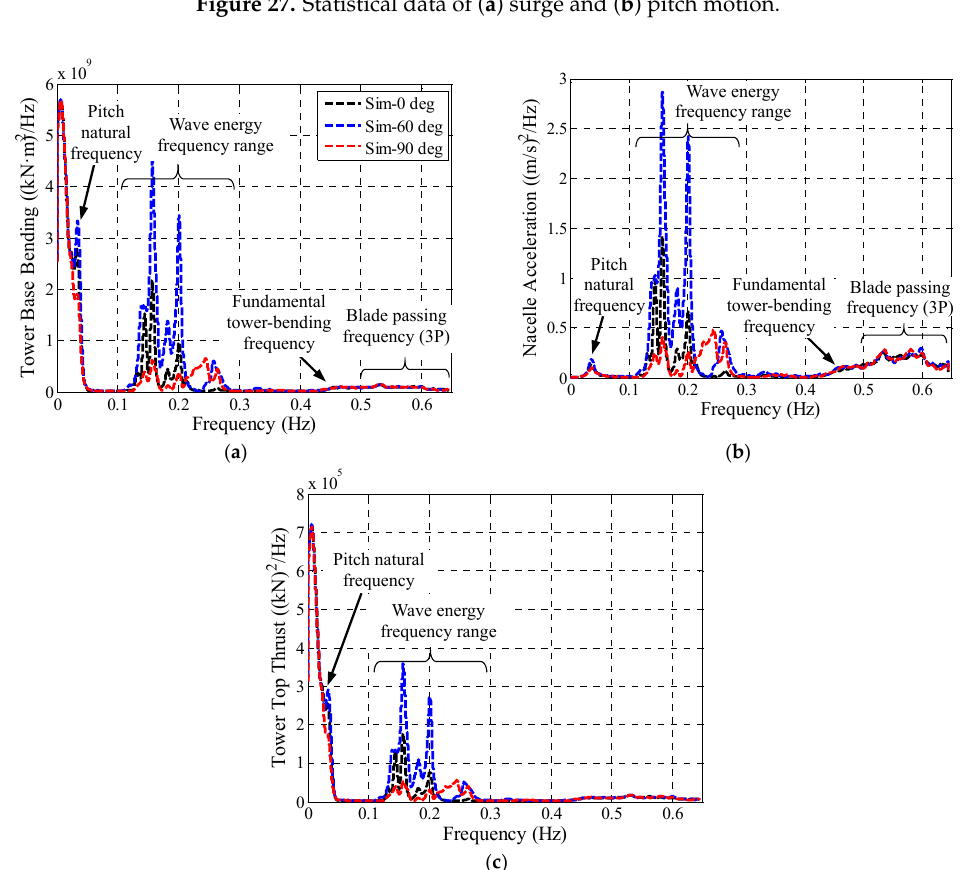
Figure 28. PSD plot of fore-aft ( a ) tower base bending moment, ( b ) nacelle acceleration and ( c ) wind